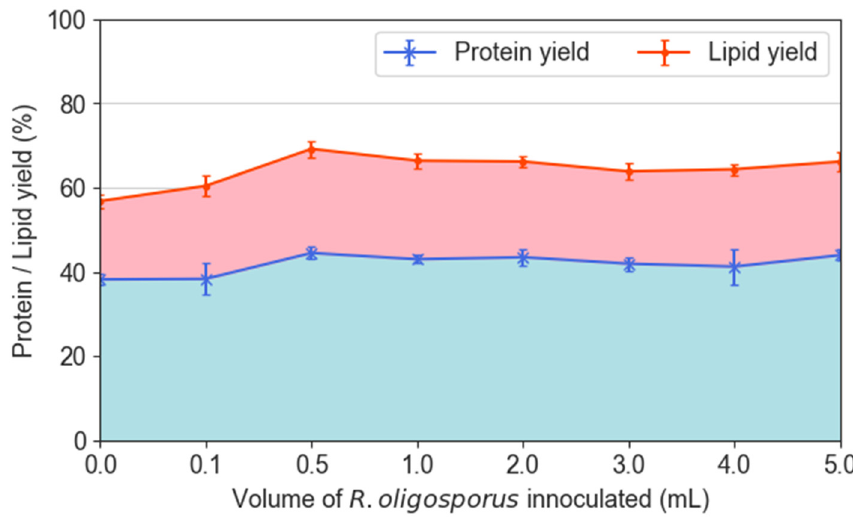
Figure 4. Protein and lipid yields from black soldier fly larvae fed palm kernel expeller containing various inoculation volumes of R. oligosporus.